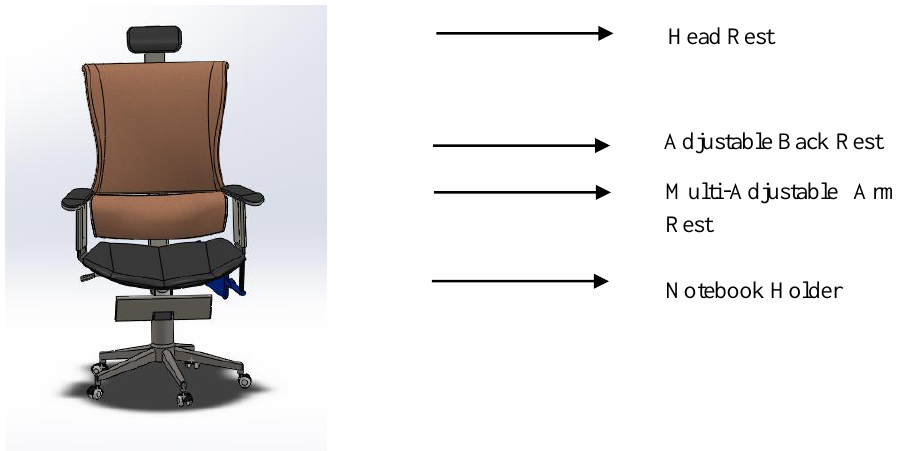
Figure 2. Designed chair in 3D front view [Designed by Solidworks 2017 x64 Edition].